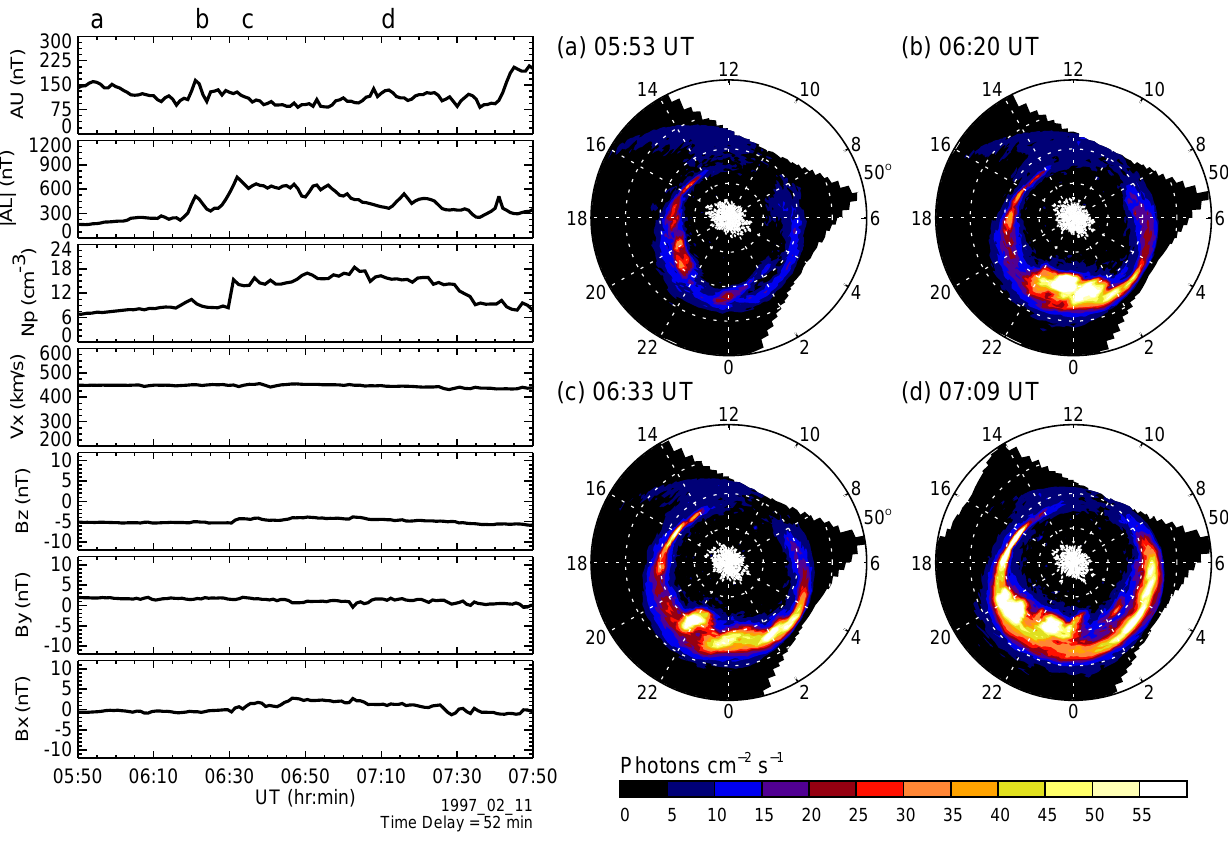
Fig. 1. The AU and | AL | indices, solar wind measurements from the Wind satellite and auroral images from Polar Ultraviolet Imager (UVI) during the period of 05:50–07:50UT, 11 February 1997. The solar wind density, N p , the X component of the solar wind velocity, V x , and the three components of the interplanetary magnetic field, B x , B y , and B z , have been shifted by 52min. We have selected four Polar UVI images that are suitable to show the development of the aurora in response to the N p enhancement. The corresponding electrojet and solar wind conditions for the four images are referred to as the labels a–d on the top of the AU